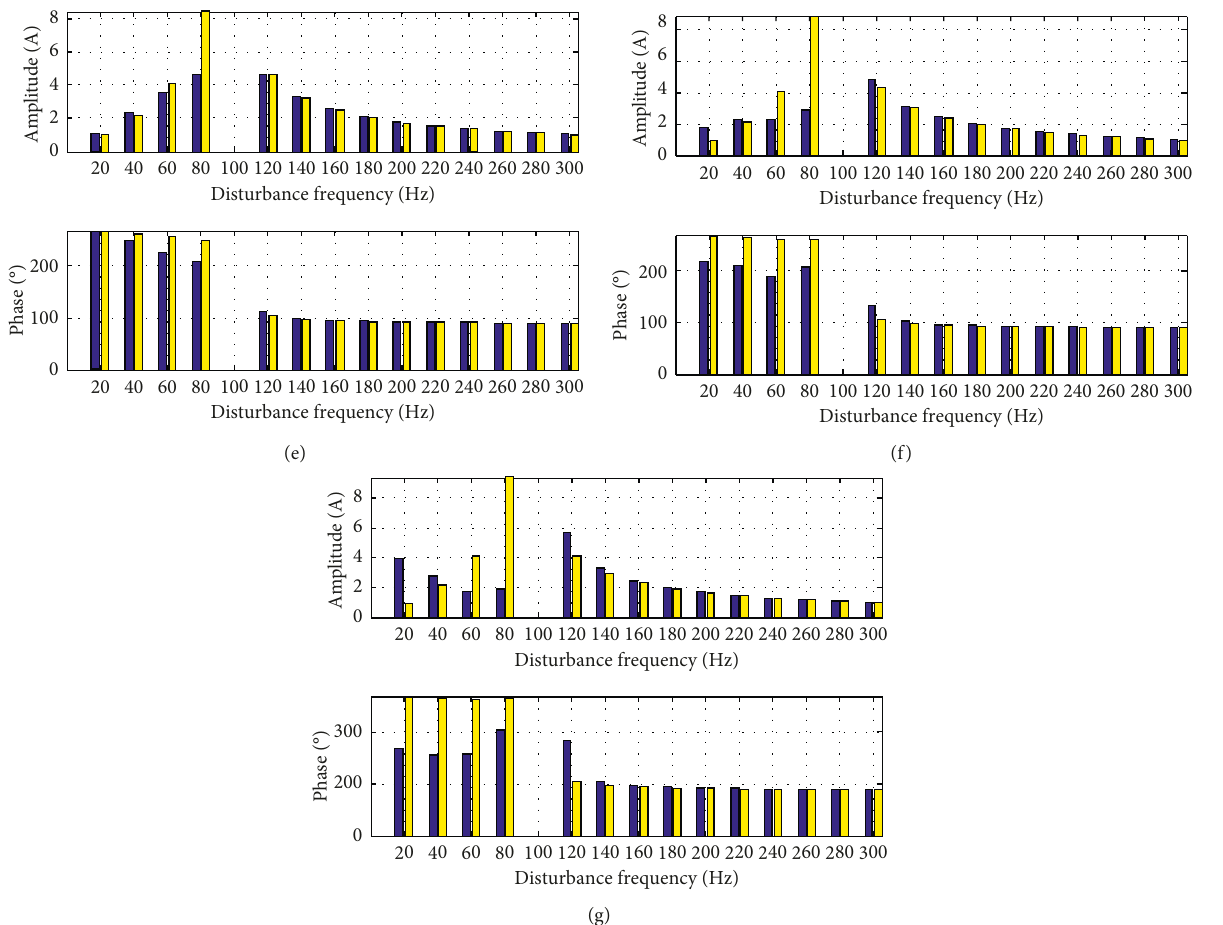
Figure 14: Output current spectrum of individual turbines in the operating point described in Tables 1 and 2, being WTG11 the closest to the offshore substation and WTG17 the furthest. Harmonic current amplitude and phase angle are represented for a switching model | ∠ θ of the DC wind turbine converter ( | I ) and for the admittance equivalent model (harmonic model) turb , sw , WTGxx turb , sw , WTGxx | ∠ θ ( | I ). (a) WTG11. (b) WTG12. (c) WTG13. (d) WTG14. (e) WTG15. (f) WTG16. (g) WTG17. turb , eq , WTGxx turb , eq , WTGxx